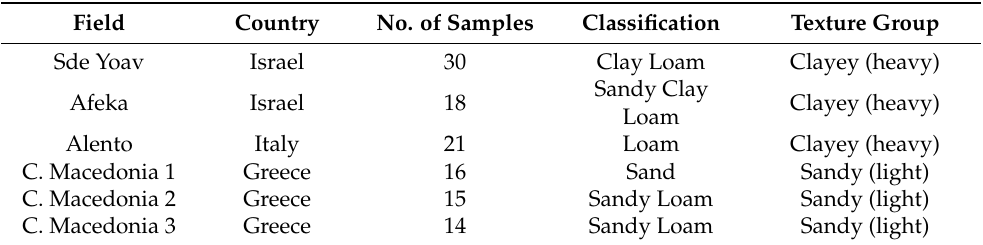
Table 1. Texture classes based on the assigned texture classification of the studied